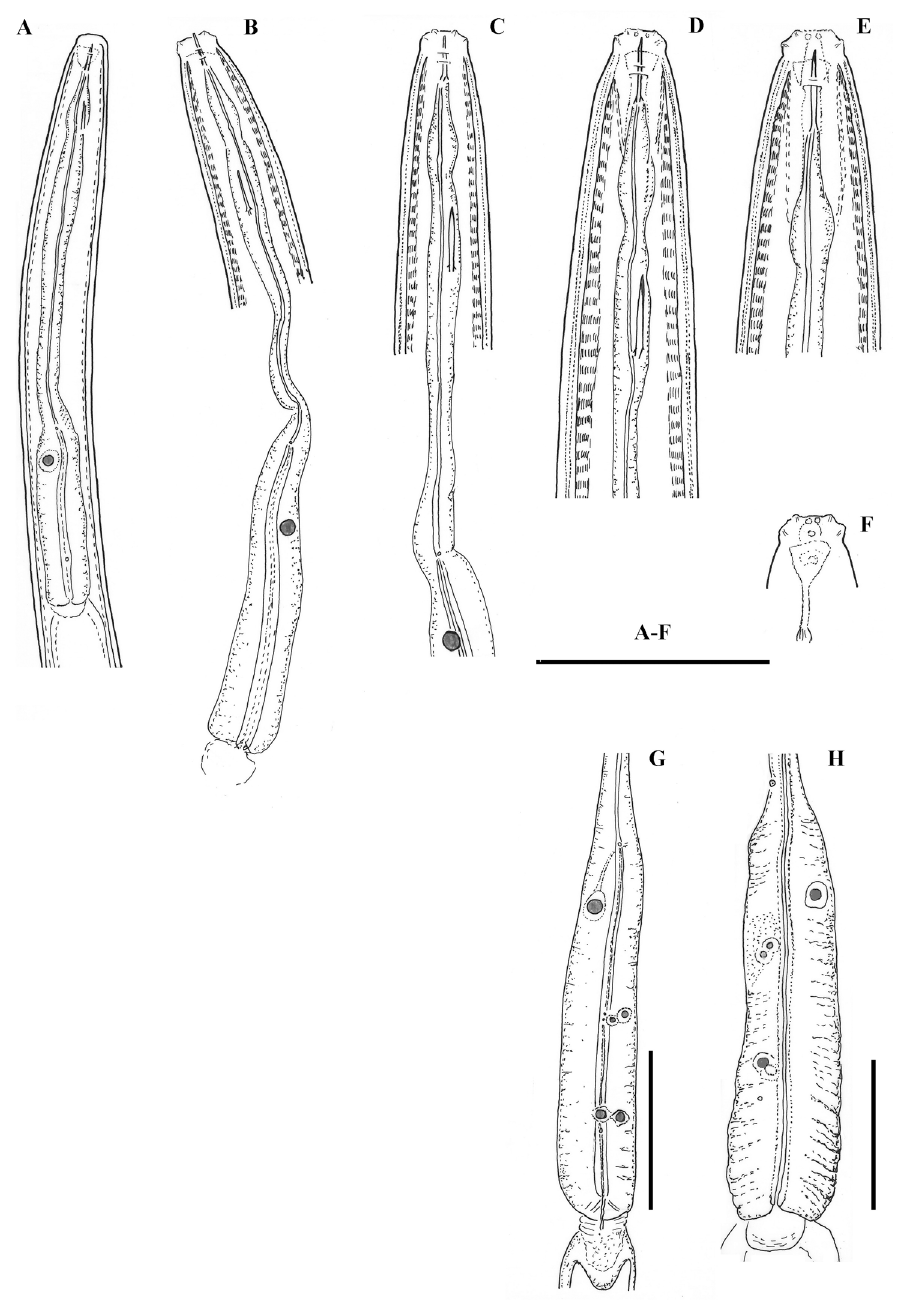
Figure 4. Enchodeloides signyensis (Loof, 1975), gen. n., comb. n. (= Enchodelus signyensis Loof, 1975). Juveniles : A–D Anterior ends (J1-J4) (specimens from Livingston Island) Female (specimen from Living- ston Island) E Anterior end F Amphideal fovea G Pharyngeal bulb . Enchodelus groenlandicus (Ditlevsen, 1927) H Pharyngeal bulb. Scale bar: 50